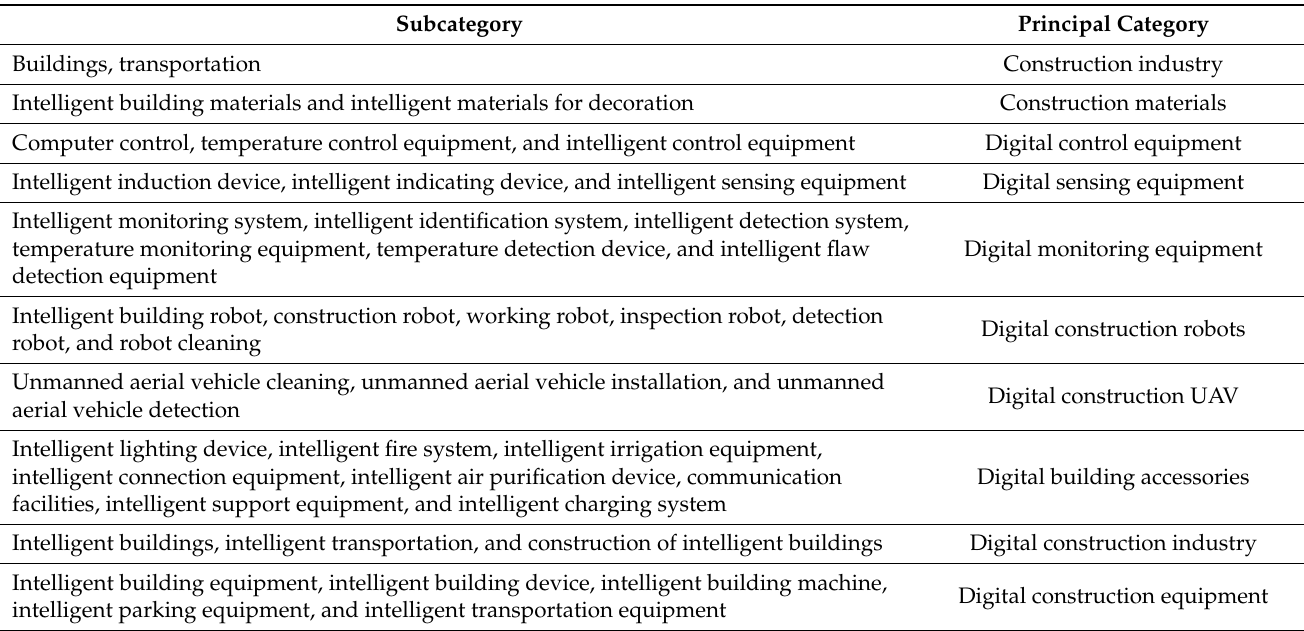
Table 3. Axial coding